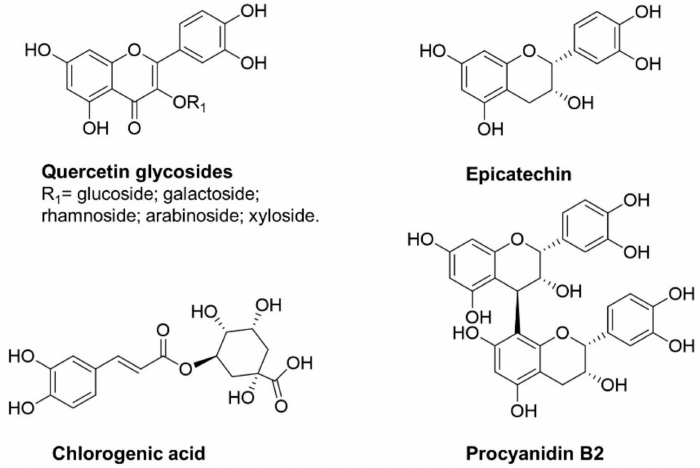
Figure 2. Apple polyphenols with a 1,2-diphenol structure as possible Nrf2 inducers. Nondiphenol apple components—phlorizin and ursolic acid—showed an activity towards Nrf2. Phlorizin is the glucoside derivative of the dihydrochalcone phloretin. In vitro and in vivo studies supported its involvement in Nrf2 activation [43–45], but